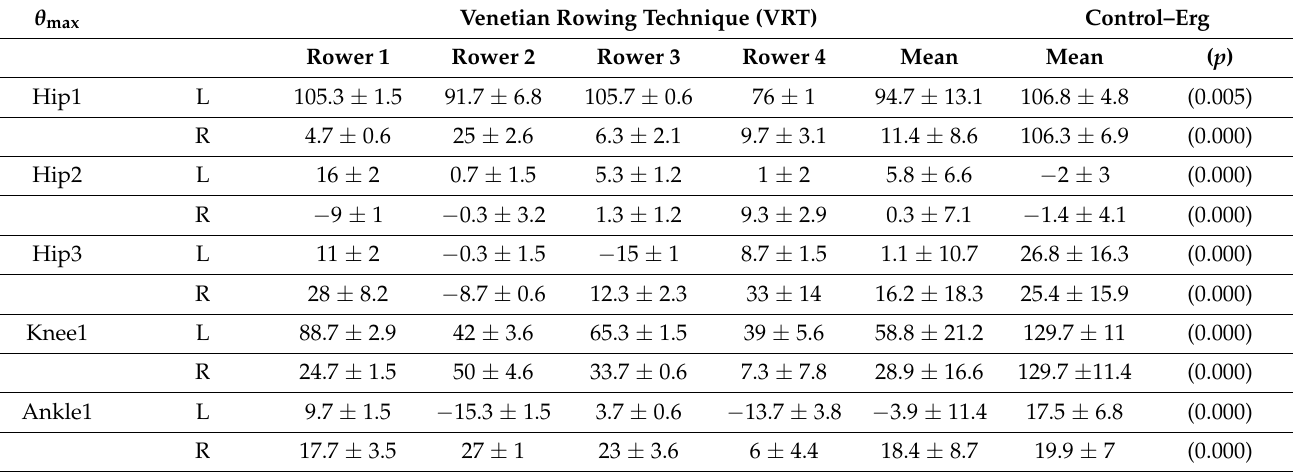
Table 6. The maximum values, θ max , of the hip, knee and ankle angles measured for the Venetian style rowing technique, in degrees, ± 1 s.d., for the individual rowers 1–4, their mean, and its equivalent mean value for standard ergometer rowing, with p -value for these two means reported in parentheses.